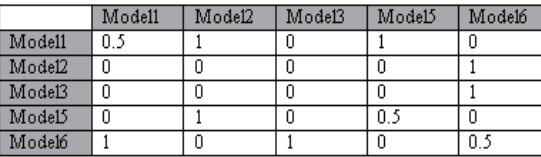
Fig. 6. Dependence matrix for the incidence matrix from Fig- ure